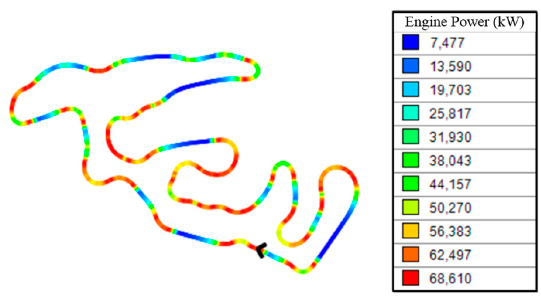
Figure 23. Optimal power developed along the FSAE autocross Germany track for the characteristics of the prototyped motor.